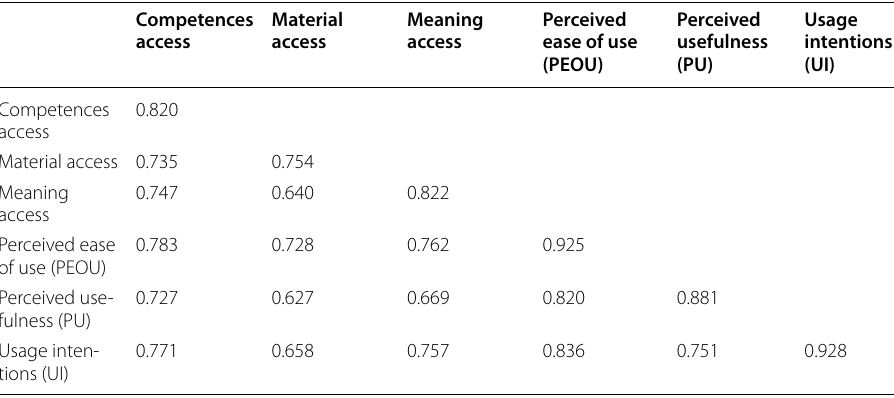
Table 4 Discriminant